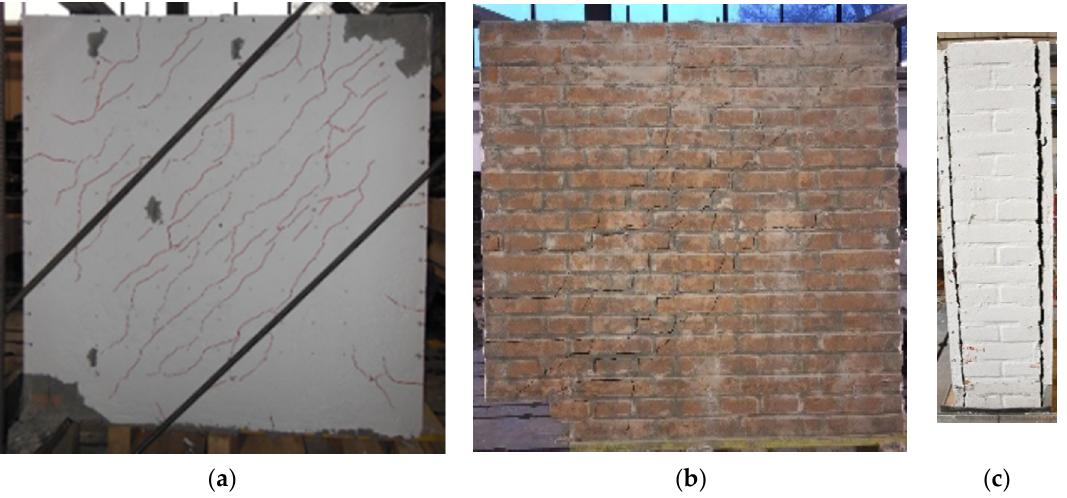
Figure 4. Damage at collapse: ( a ) on the plaster; ( b ) on the masonry; ( c ) plaster detachment.